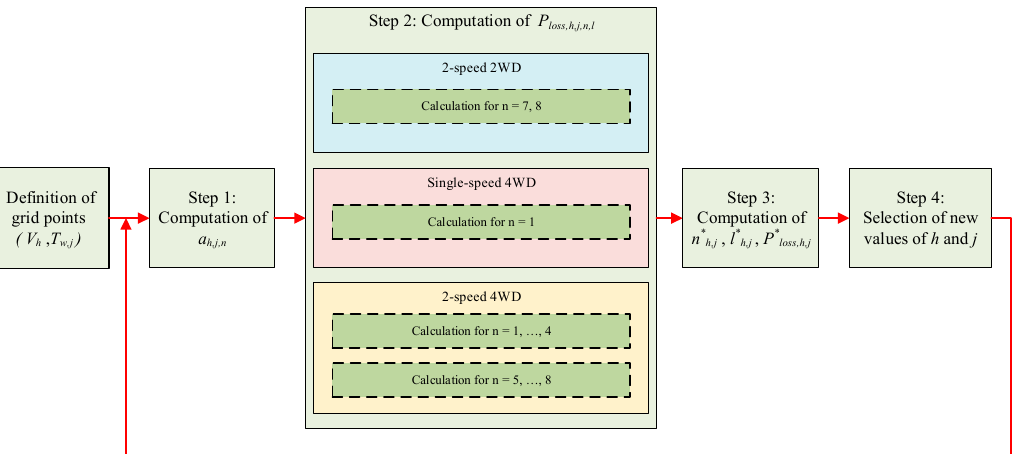
Figure 10. Simplified flow chart of the optimal state and front-to-total wheel torque distribution search routine.